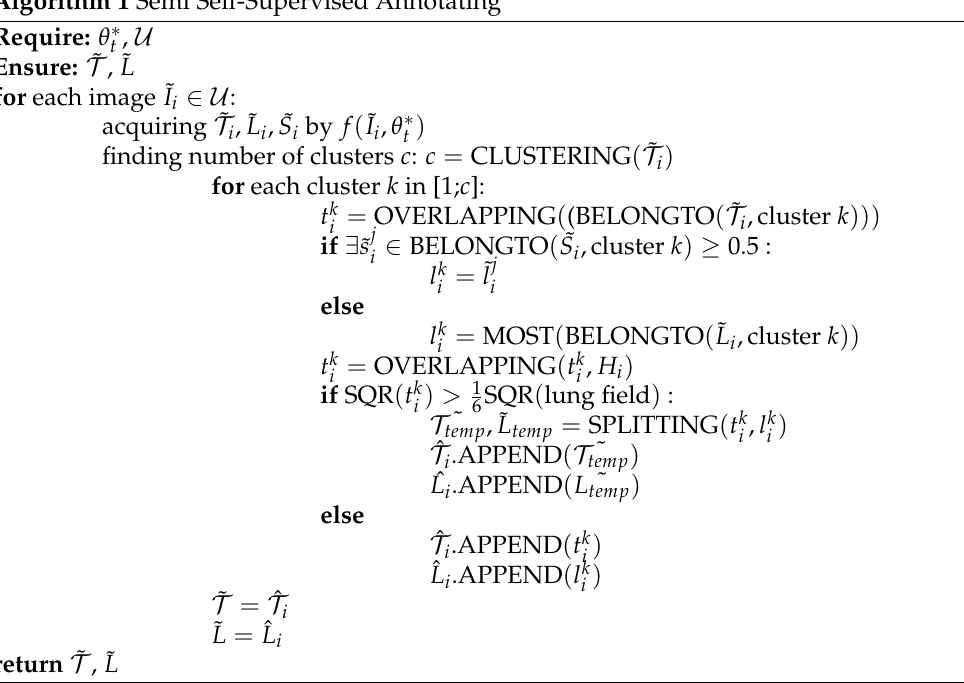
Algorithm 1 Semi Self-Supervised Annotating